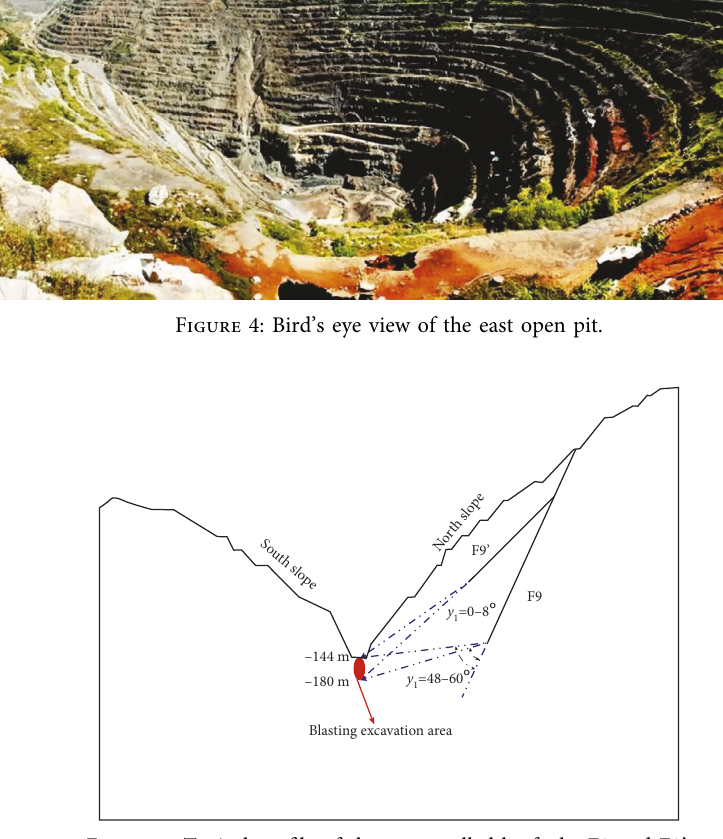
Figure 5: Typical profile of slope controlled by faults F9 and F9’.